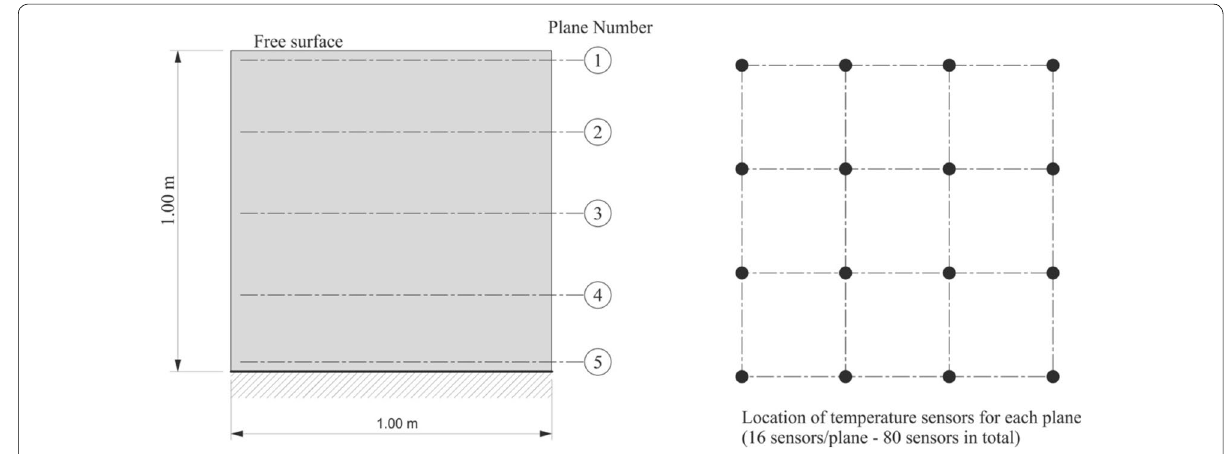
Fig. 9 Distribution of the temperature sensors within the concrete